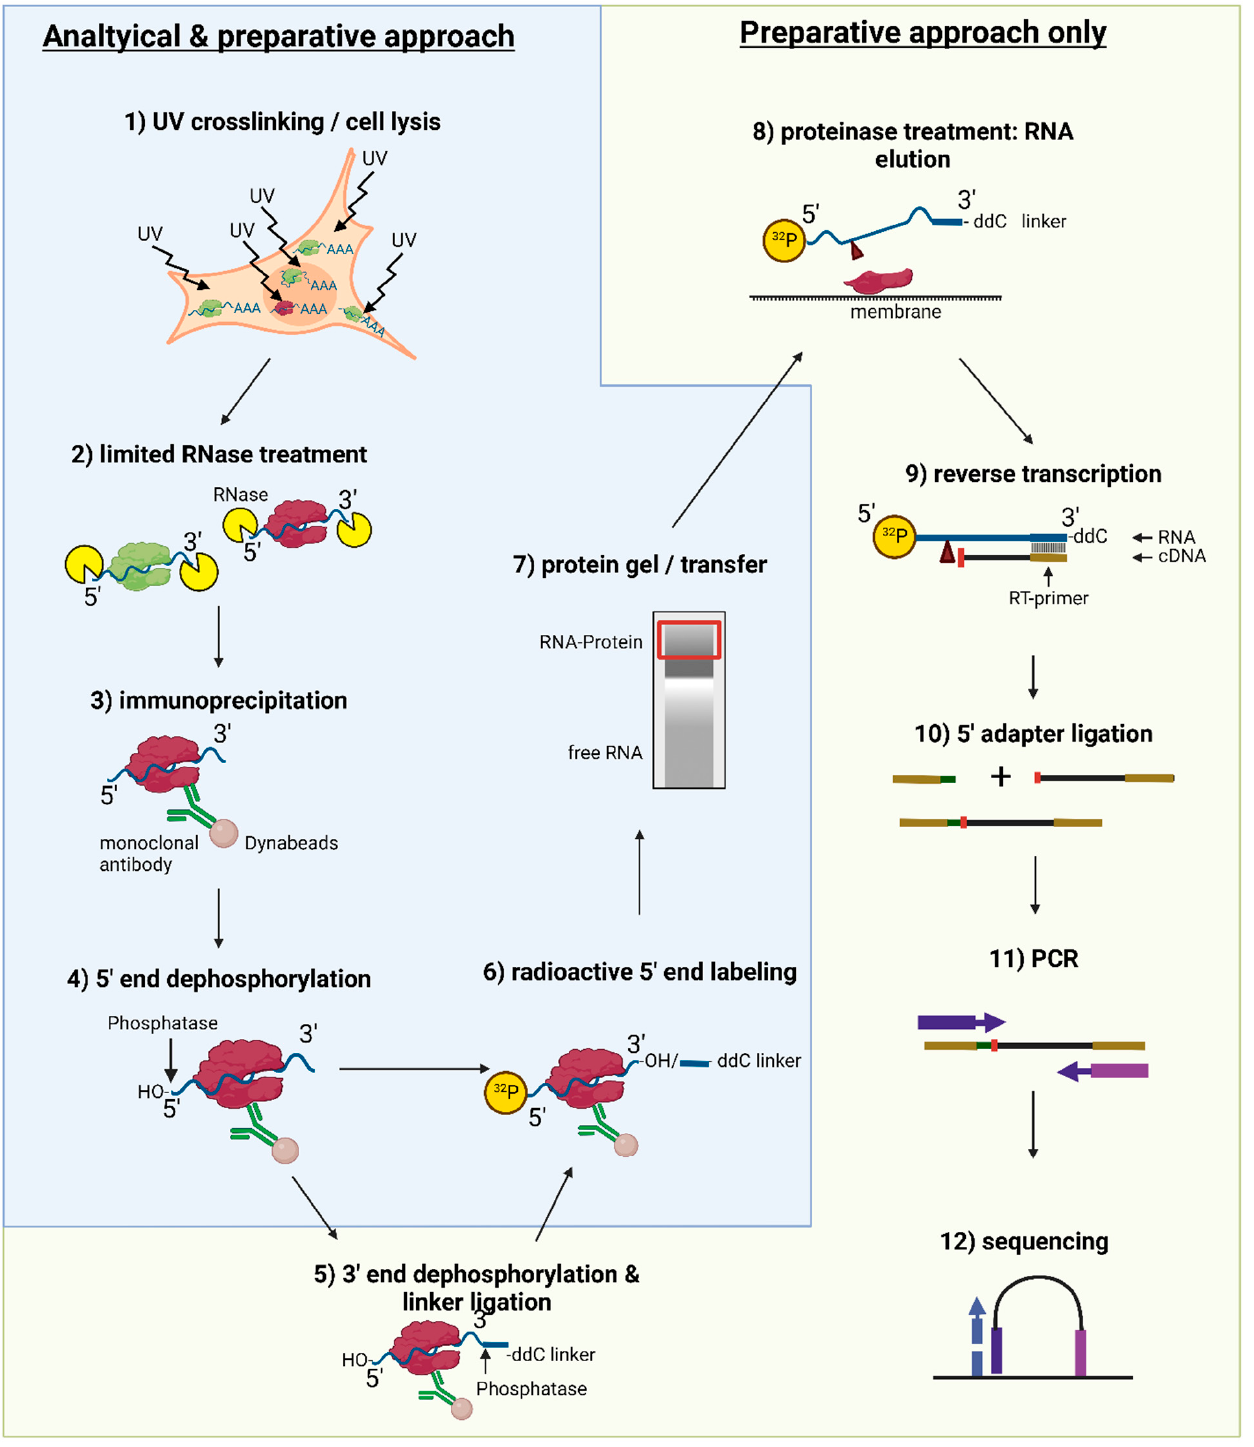
Figure 1. Overview over the iCLIP2 protocol. Experimental steps necessary for both analytical and preparative approaches (UV crosslinking and cell lysis, limited RNase treatment, IP, 5 (cid:48) end dephosphorylation, radioactive 5 (cid:48) end labeling, protein gel, and membrane transfer) are indicated by a blue color background and outline. A green background and outline indicate additional steps only necessary for a preparative approach (additional 3 (cid:48) end dephosphorylation and 3 (cid:48) -linker ligation, proteinase treatment for RNA elution from the membrane, reverse transcription, 5 (cid:48) adapter ligation, PCR, and